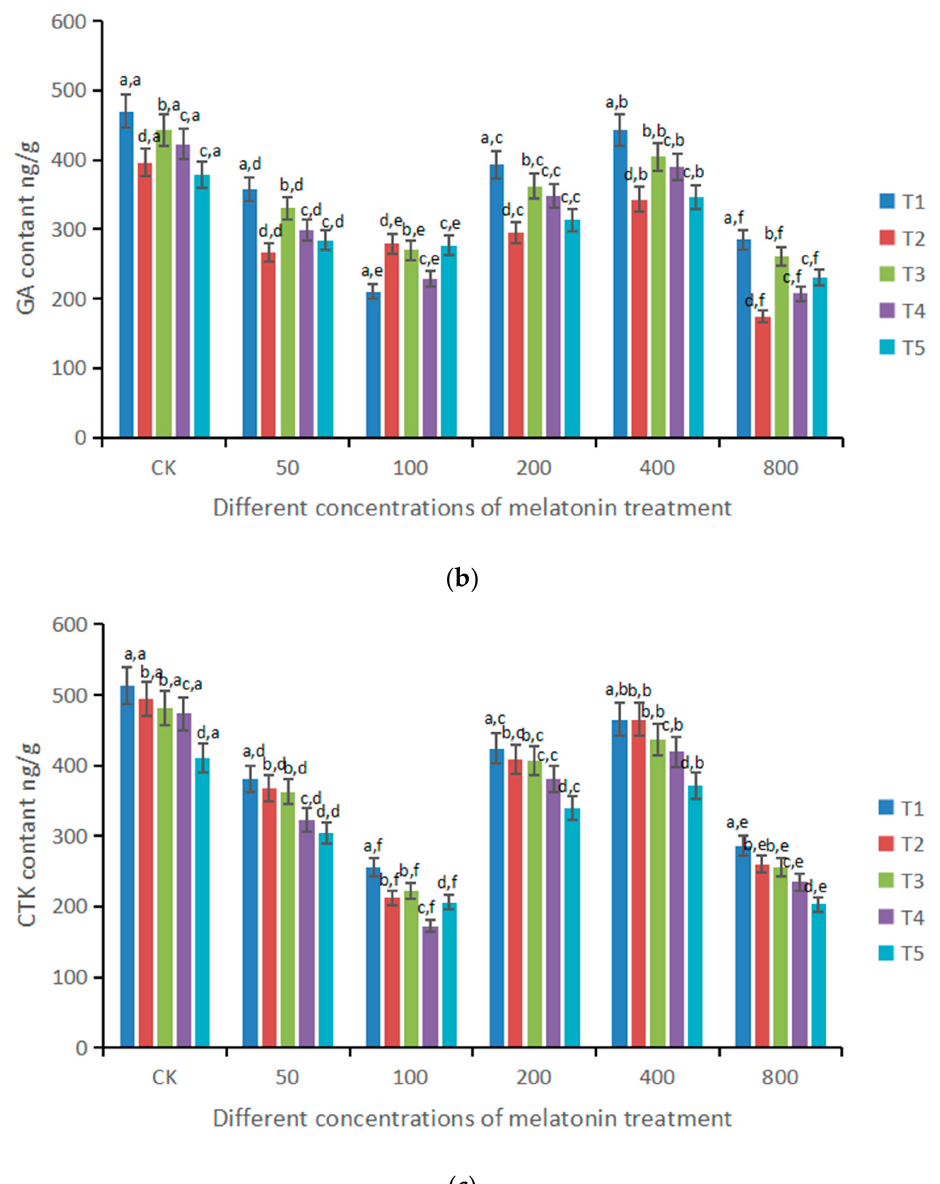
Figure 5. Relative IAA, CTK, and GA content of Populus cathayana × canadansis ‘Xin lin 1’ leaves under control and different MT treatments based on salt and alkaline stress in different time periods of the experiment. T1 means 10 days, T2 means 14 days, T3 means 18 days, T4 means 22 days, T5 means 26 days. Each value is the average ± standard error (±SE). For two ‐ way ANOVA, the letters on the left represent the detection phase ( p < 0.05) and the letters on the right represent the experimental concentrations ( p < 0.05). ( a ) Changes of IAA content, ( b ) changes of GA content, ( c ) changes of CTK content.